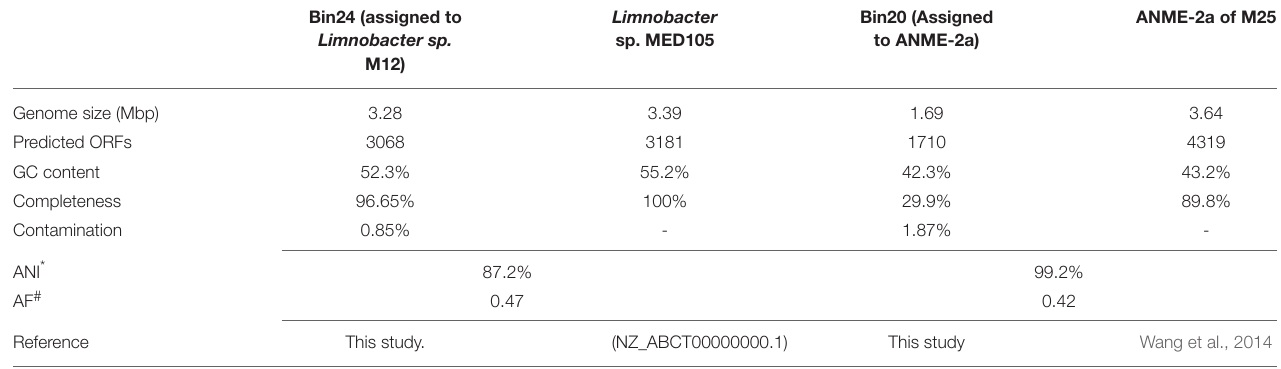
TABLE 1 | Overview of genome features.